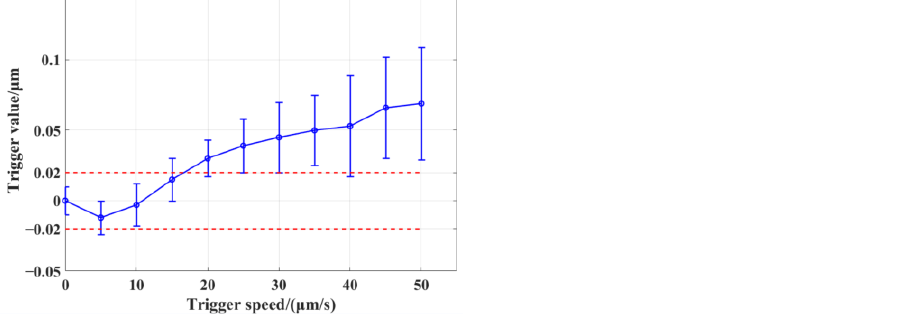
Figure 10. The relationship between the trigger speed of the moving axis and the coordinate value collected by the moving axis.